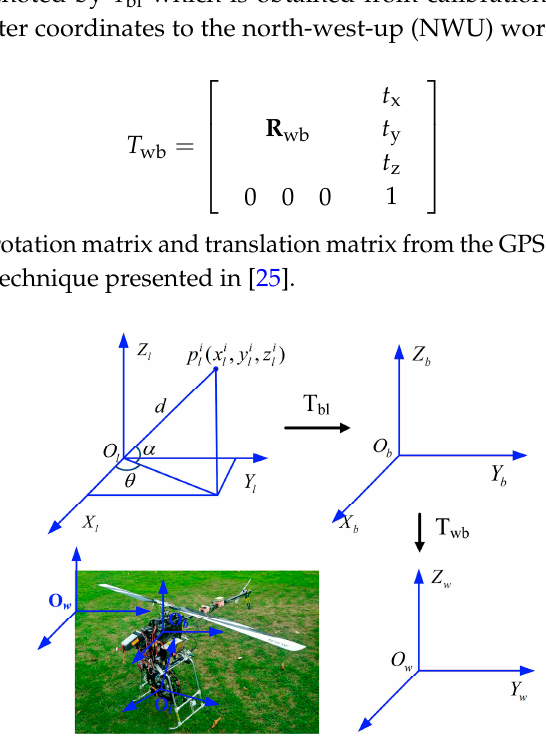
Figure 4. Coordinate system transformations for the small unmanned helicopter with a lightweight laser scanning system.